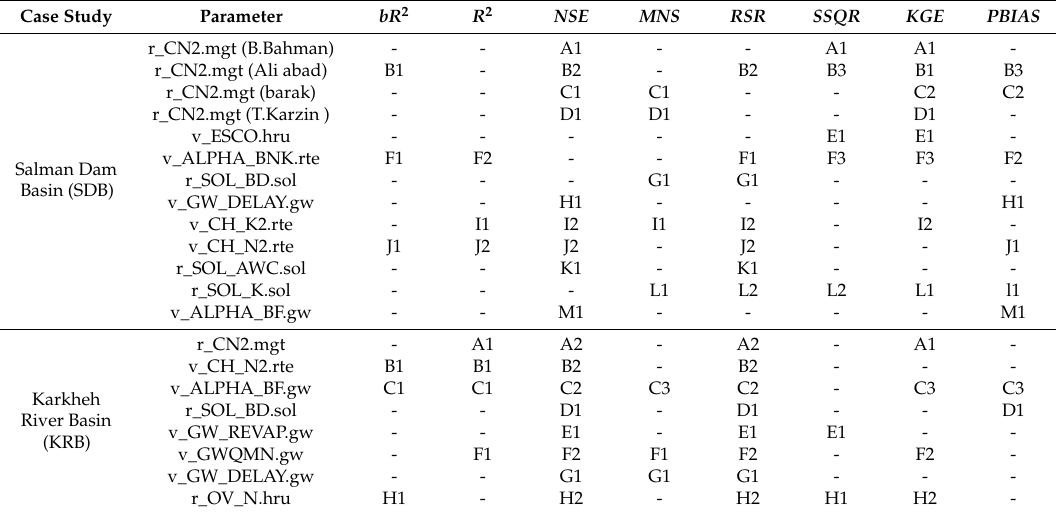
Table 7. Results of Tukey’s post-hoc test to determine if parameters obtained by different objective functions were statistically different or similar.